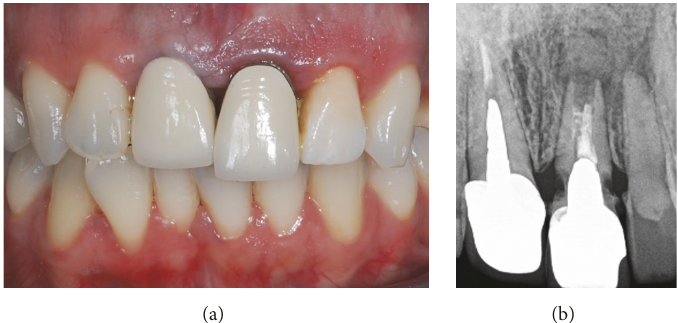
Figure 1: Preoperative situation. The patient complains because the left central incisor, which was restored with a single crown several years before, appears extruded and presents a high mobility (a). The periapical radiograph shows a severe resorption (b): the tooth is nonrestorable and needs to be extracted.